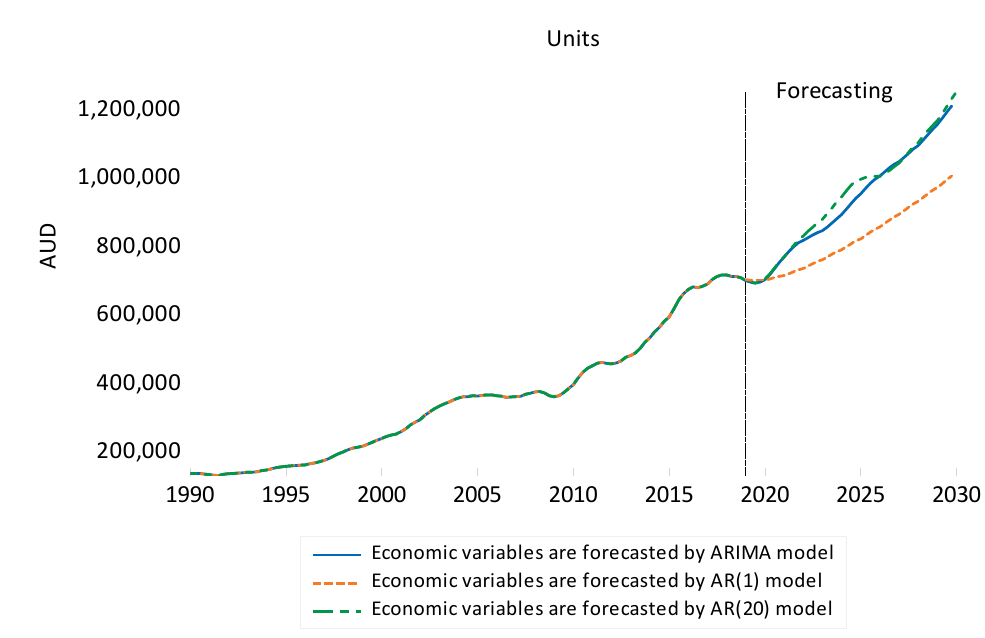
Figure 2. Forecasted Median Prices,